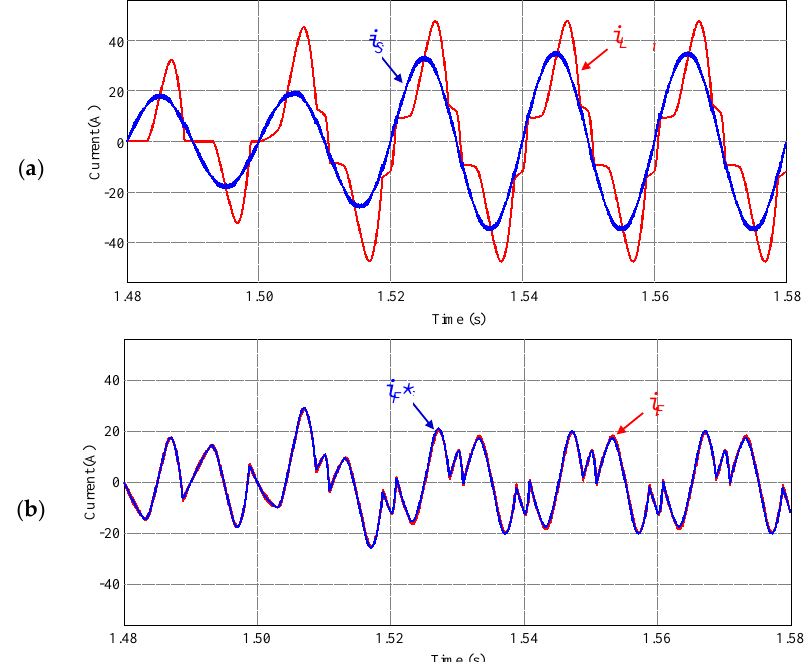
Figure 14. Transient analysis of the SAPF operation with the connection of a non-linear load: ( a ) Load ( i L ) and source ( i S ) currents; ( b ) SAPF reference ( i F *) and actual ( i F ) compensation current.